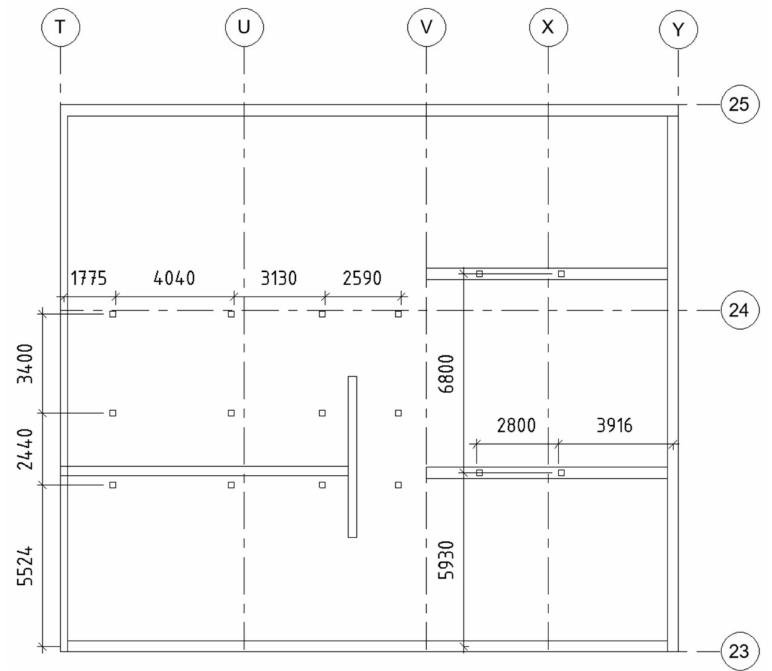
Figure 5. Plan of attic (unit: mm).